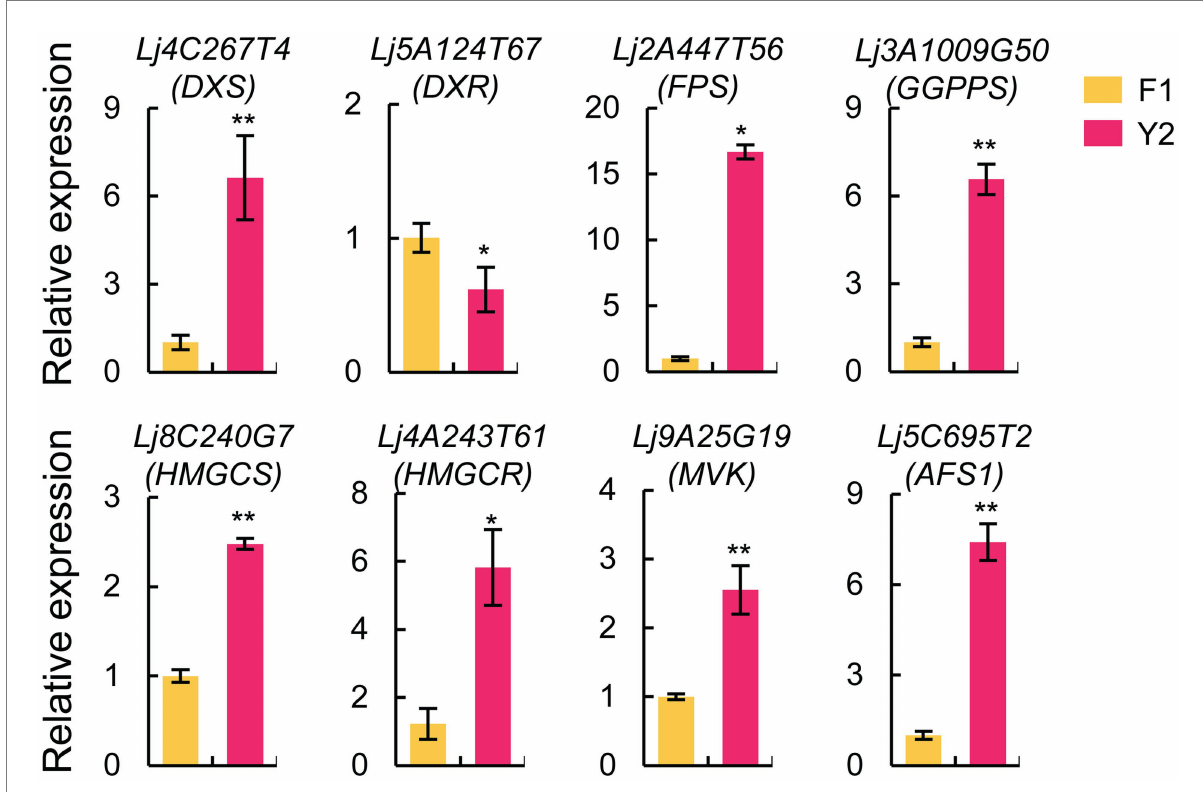
FIGURE 7 Expression analysis of candidate genes involved in the terpenoid biosynthetic pathway based on quantitative real-time PCR (qRT-PCR). The actin gene was used as an internal reference. The values are presented as the mean ± standard deviation ( n = 3). Significant differences between ‘Yujin2’ and ‘Fengjin1’ are marked with asterisks (** p < 0.01, * p < 0.05, Student’s t -test). AFS1, alpha-farnesene synthase; DXR, 1-deoxy-D-xylulose-5- phosphate reductoisomerase; DXS, 1-deoxy-D-xylulose-5-phosphate synthase; FPS, farnesyl diphosphate synthase; GGPPS, geranylgeranyl diphosphate synthase; HMGCR, hydroxymethylglutaryl-CoA reductase; HMGCS, hydroxymethylglutaryl-CoA synthase; MVK, mevalonate